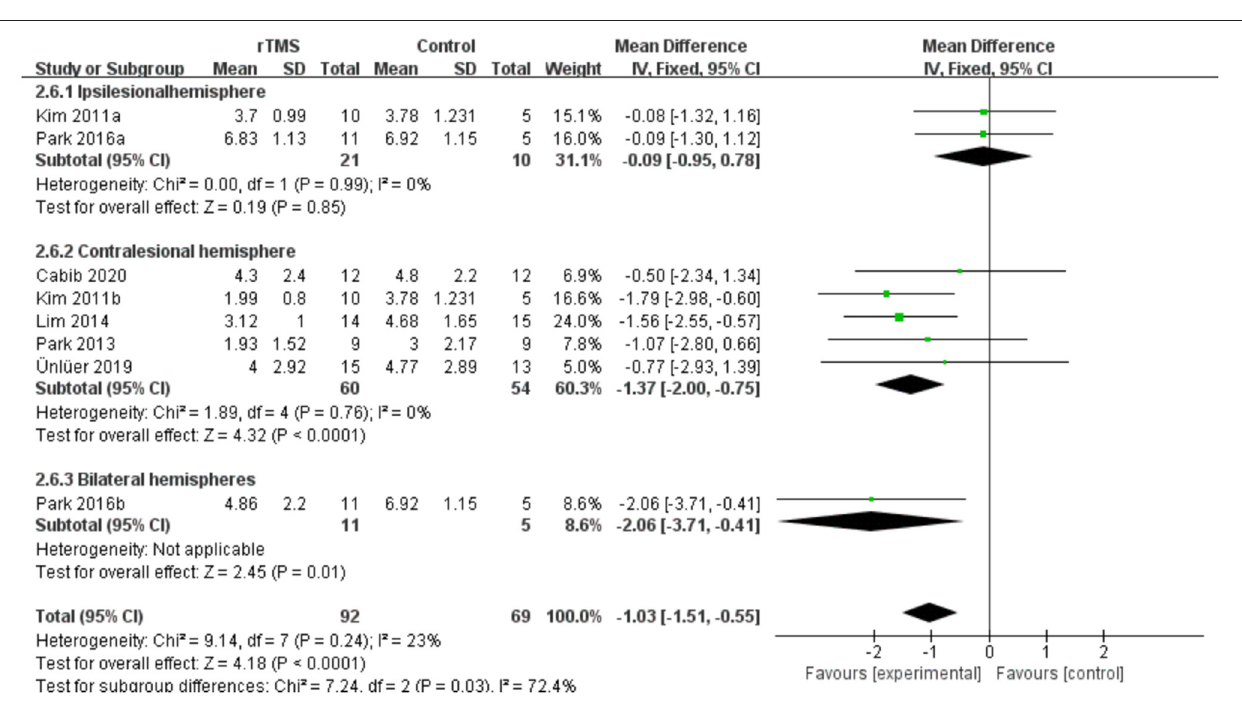
FIGURE 8 | Forest plot for subgroup analysis for Penetration Aspiration Scale: ipsilesional hemisphere vs. contralesional hemisphere vs. bilateral hemispheres.